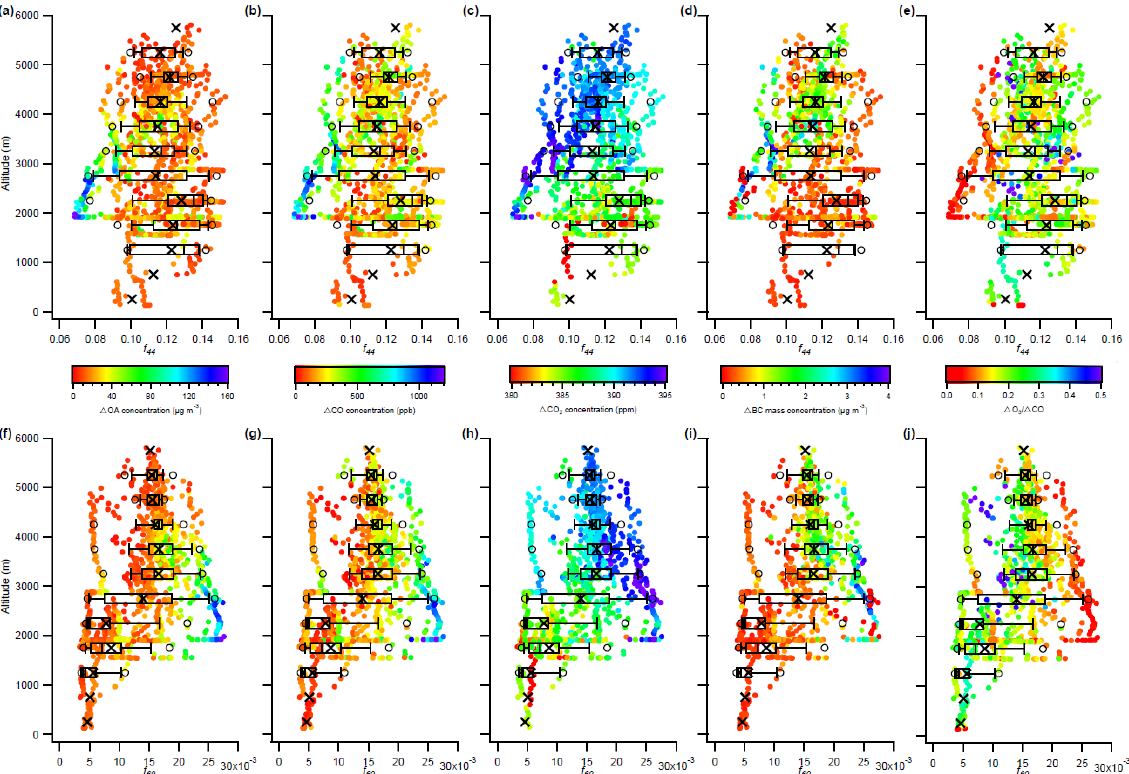
Figure 7. Vertical profiles of (a–e) f 44 and (f–j) f 60 in aged plumes. Data points are coloured by (a+f) (cid:49) OA, (b+g) (cid:49) CO, (c+h) CO 2 , (d+i) (cid:49) BC and (e+j) (cid:49) O 3 /(cid:49) CO. Circles represent the 5th and 95th percentiles, vertical lines the 10th, 25th, 50th, 75th and 90th percentile, with crosses denoting mean values in each 500m altitudinal